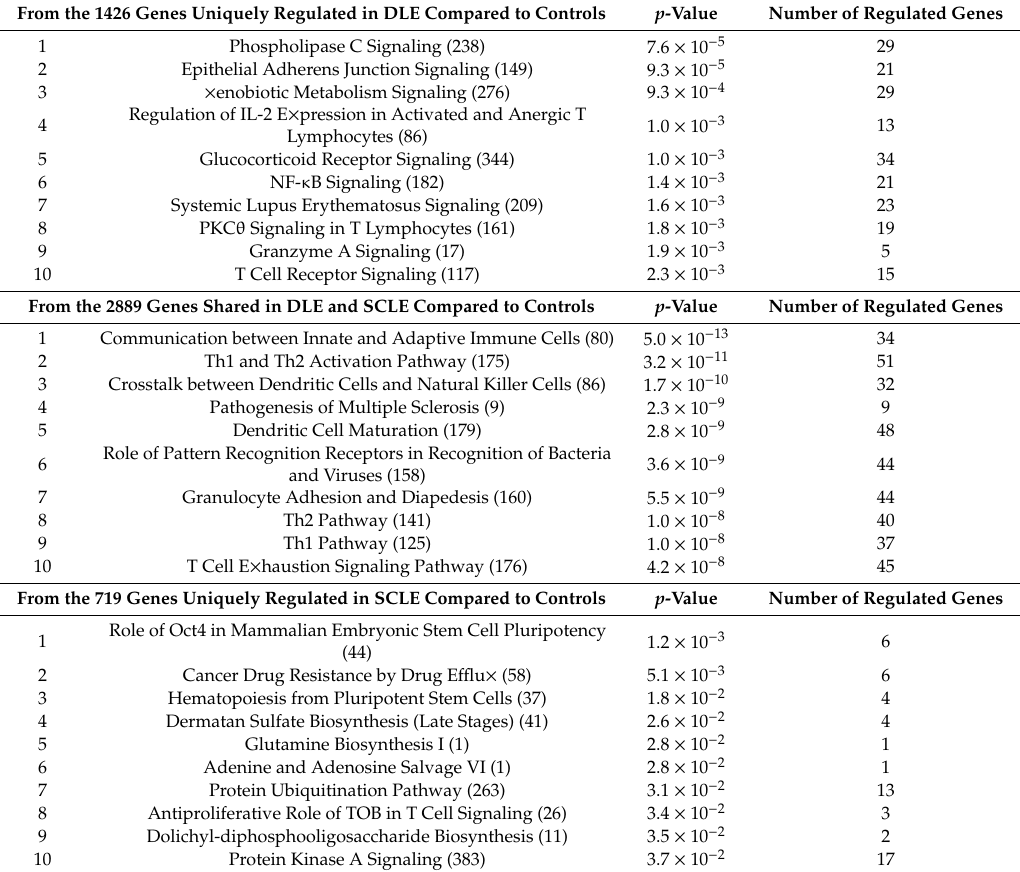
Table 2. Ingenuity Pathway Analysis: Top 10 canonical pathways from the genes uniquely regulated in DLE, SCLE and in both lesion types compared to controls (the total number of genes in each pathway is indicated in